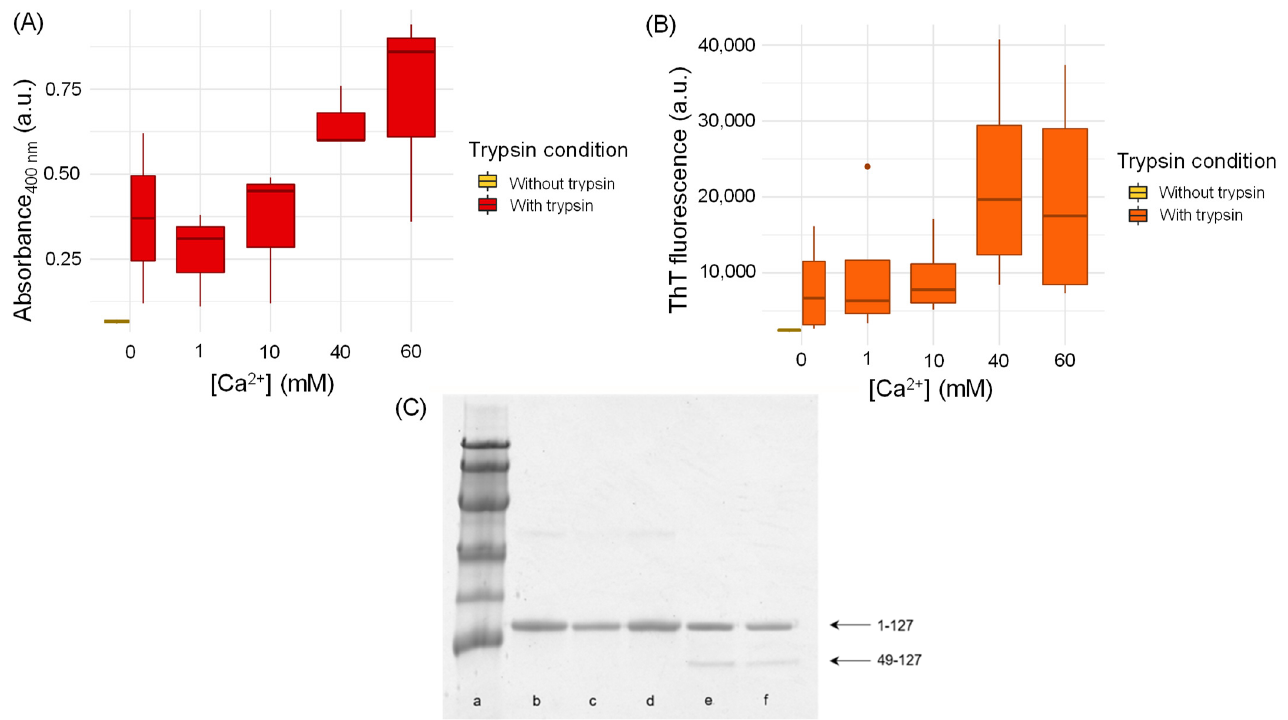
Figure 5. Effect of calcium on mechano-enzymatic wild type TTR fibrillogenesis. ( A ) Light scattering signal at 400 nm monitored in the whole sample after 96 h of aggregation. ( B ) ThT emission fluorescence at 480 nm following excitation at 445 nm measured in pellets after 96 h of aggregation. Statistical analysis on both turbidity and ThT aggregation data was performed using the Friedman test. ( C ) SDS 15% PAGE under reducing conditions. Lane a: marker proteins (14.4, 20.1, 30.0, 45.0, 66.0 and 97.0 kDa); lane b: WT TTR; lane c: WT TTR 1 mM Ca 2+ ; lane d: WT TTR 10 mM Ca 2+ ; lane e: WT TTR 40 mM Ca 2+ ; lane f: WT TTR 60 mM Ca 2+ . 1–127 and 49–127 indicate full- length TTR and the amyloidogenic C-terminal fragment, respectively.